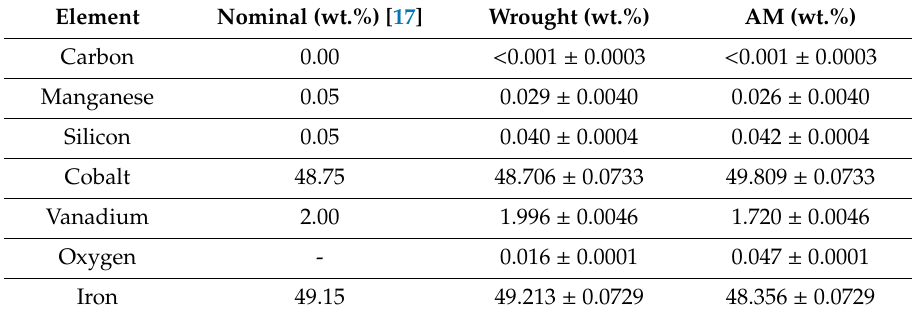
Table 2. Nominal composition of Hiperco 50A and measured chemistry with test precision for wrought and AM